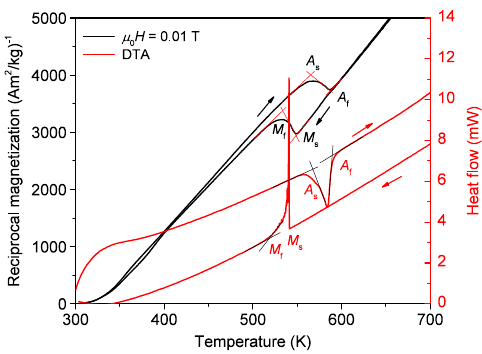
Figure 3. Reciprocal magnetization or susceptibility of Ni 49.9 Mn 24.6 (Ga 20.4 Co 5.1 ) exhibiting marten- sitic transformation (MT) above Curie temperature of martensitic phase. Differential thermal analysis (DTA) measurement of the same sample confirming MT